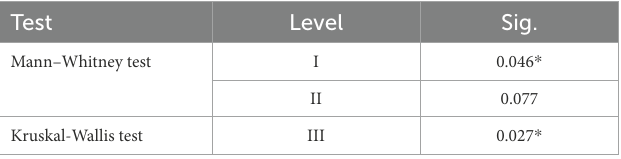
TABLE 4 Non-parametric tests.